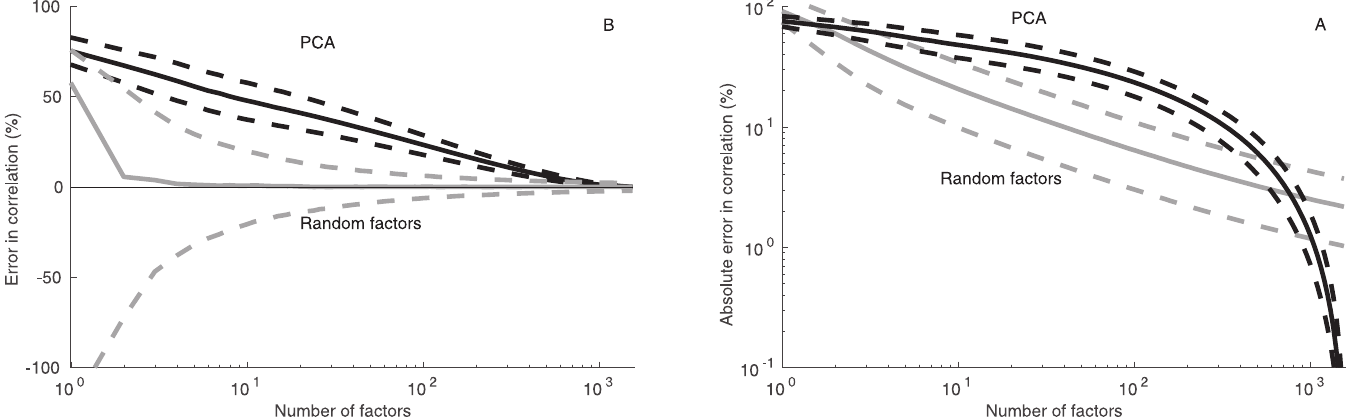
Fig 3. Accuracy of the correlation modeling. (A) Median error (solid gray curves; measured in percentage points) in correlation coefficient estimates in all pairs in the data-set estimated using 1,000 different random factor models, together with the 25th and 75th (dashed gray curves) percentiles of error in correlation estimates. The results are compared with the estimates of correlation based on PCA (solid black curve), together with the 25th and 75th (dashed black curves) percentiles. The results are shown as a function of the number of factors (abscissa). (B) Median absolute error of the random factor model (solid grey curve; measured in percentage points), together with the 25th and 75th percentiles (dashed grey curves); Median error in PCA (solid black curve) and the 25th and 75th percentiles (dashed black curves).